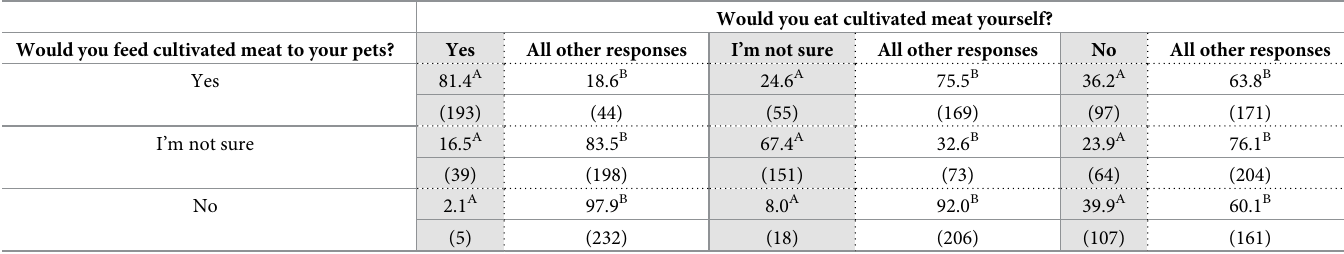
Survey respondents are grouped according to willingness to eat cultivated meat. Feeding preferences are shown as percentage and number in parentheses. Superscript letters indicate significant differences within rows (between levels of willingness to feed cultivated meat to pets) as determined by the two-sided test of equality for proportions where ab indicates p < 0.05 and AB indicates p < 0.001. Three separate tests of quality were performed in Table 5 –one for each of the three columns. The test in the first column compares those willing to eat cultivated meat against all other responses. The test in the second column compares those unsure about eating cultivated meat against all other responses. The test in the third column compares those not willing to eat cultivated meat against all other responses.